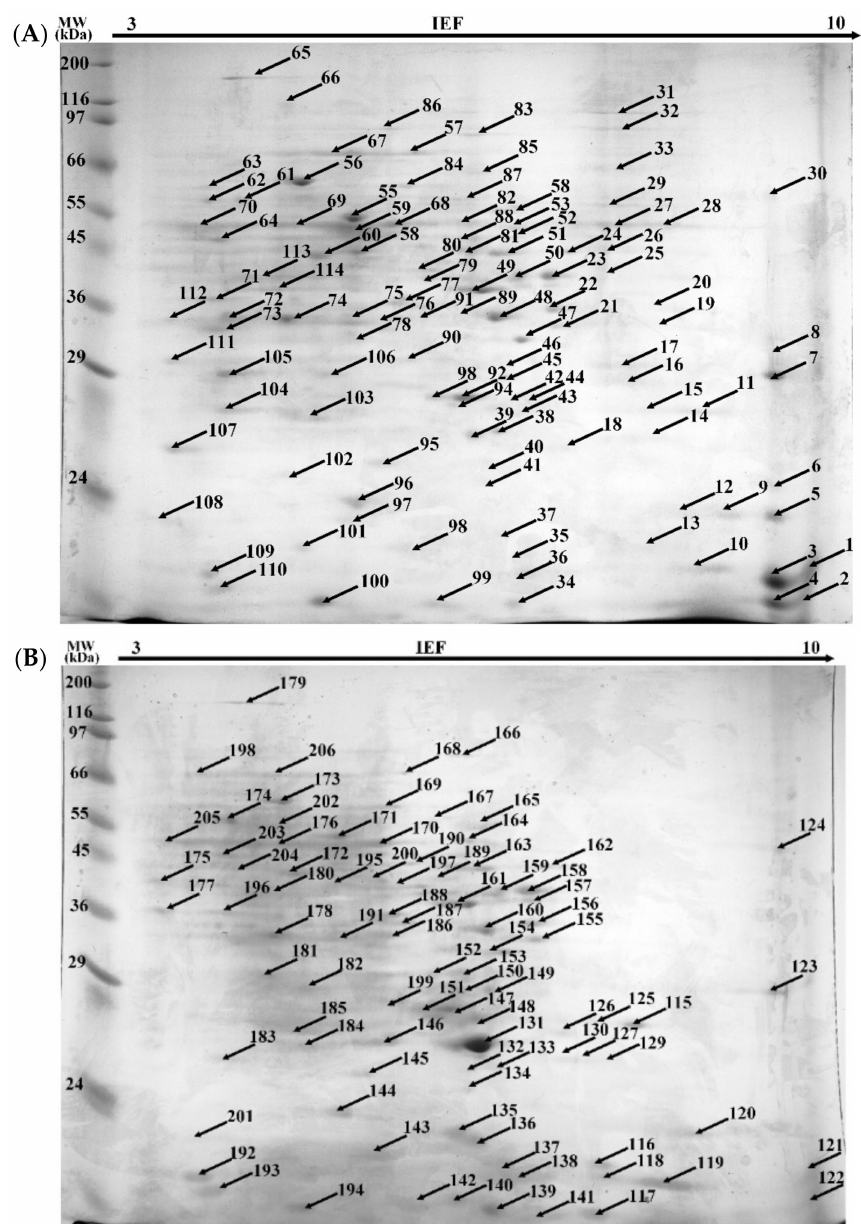
Figure 3. Representative 2-DE gels of intracellular proteome of M. roridum IM 6482 obtained from ( A ) control cultures (without BPA) and ( B ) after exposure to 50 mg · L − 1